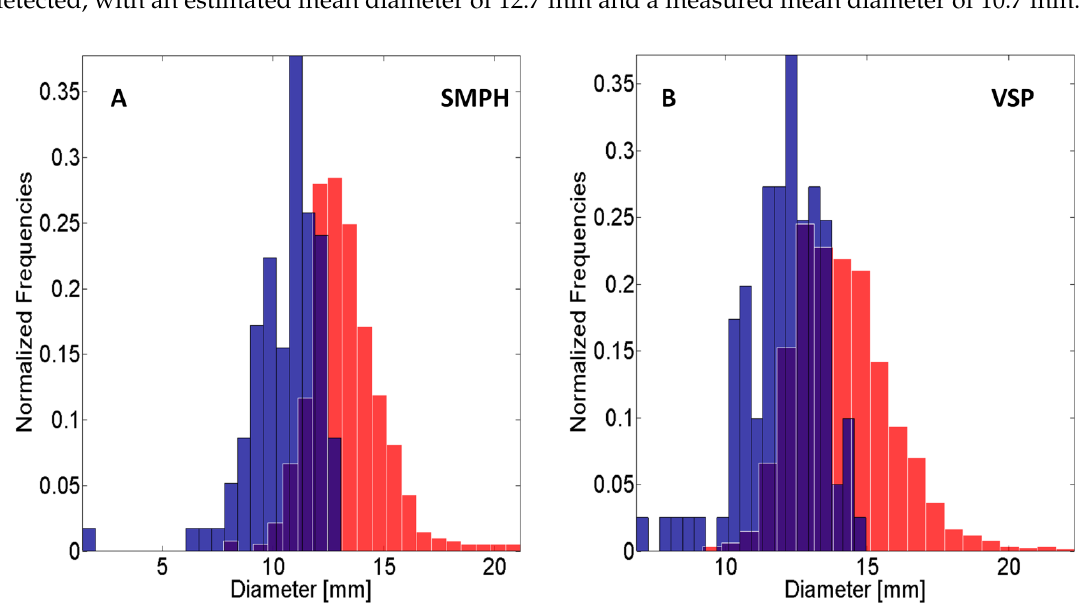
Figure 19. ( A ) Normalized histograms for the berry diameter of the SMPH row; ( B ) Normalized histograms for the berry diameter of the VSP trellis row. Red : Estimated with findBerries. Blue : Measured manually in the field. Purple : Area of overlap between both